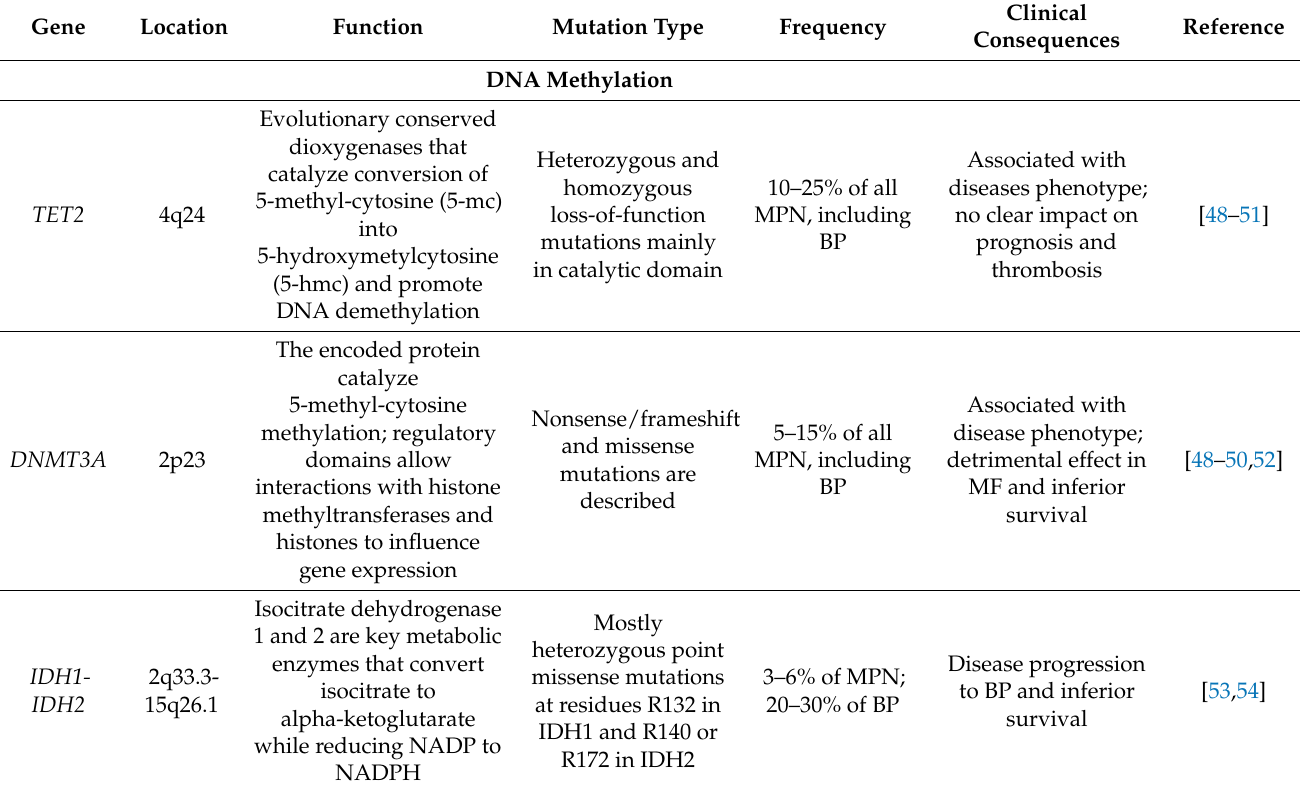
Table 1. Somatic additional mutations in